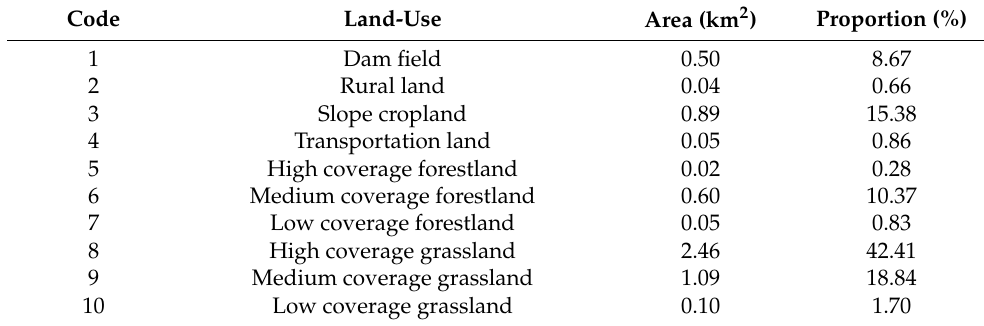
Table 2. Land uses in the WMG